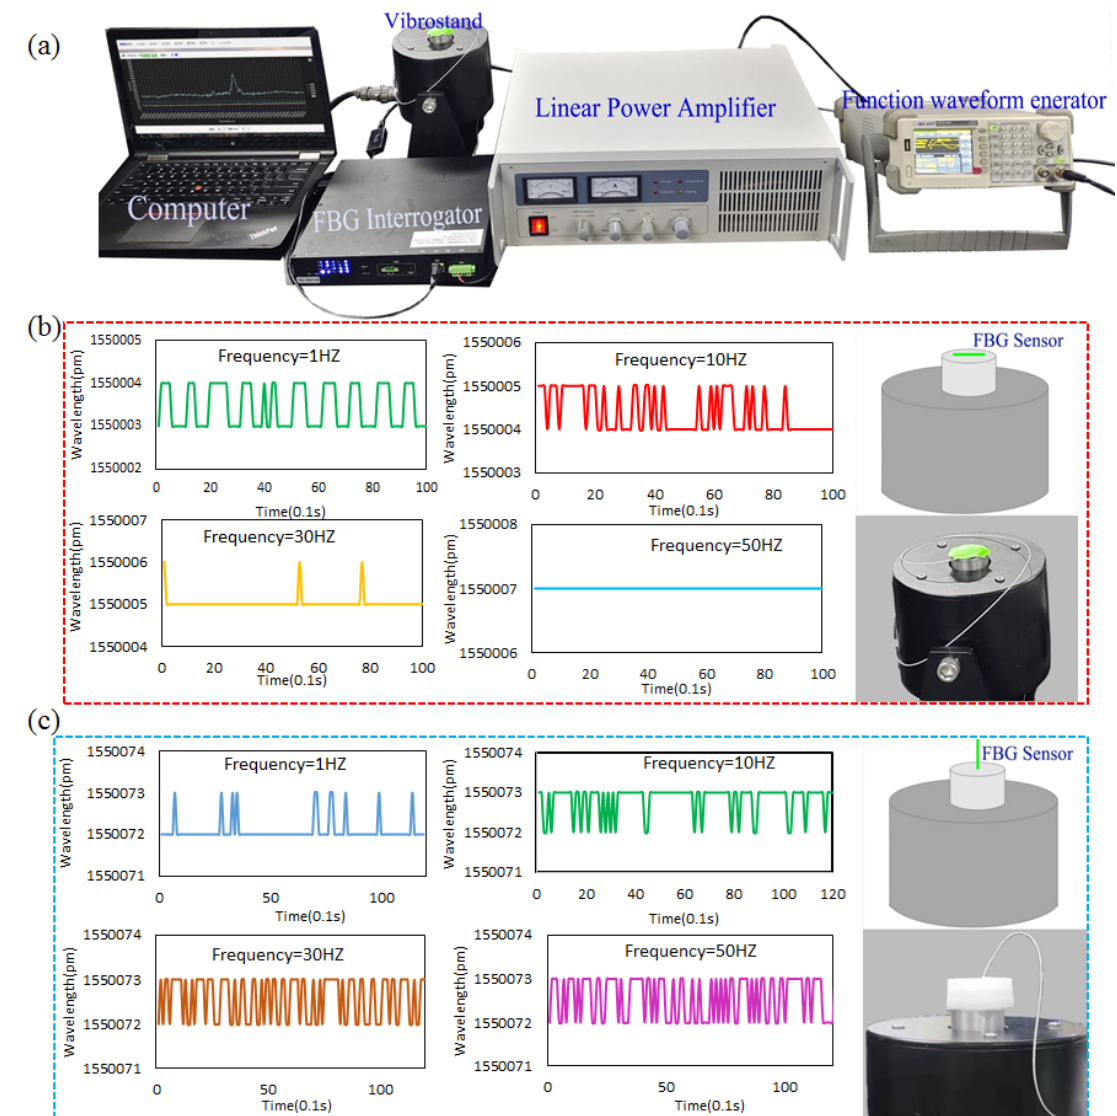
Figure 4. Anti-vibration performance test of FBG sensor, ( a ) the experiment setup, ( b , c ) the wave- length changes with different vibration frequencies.